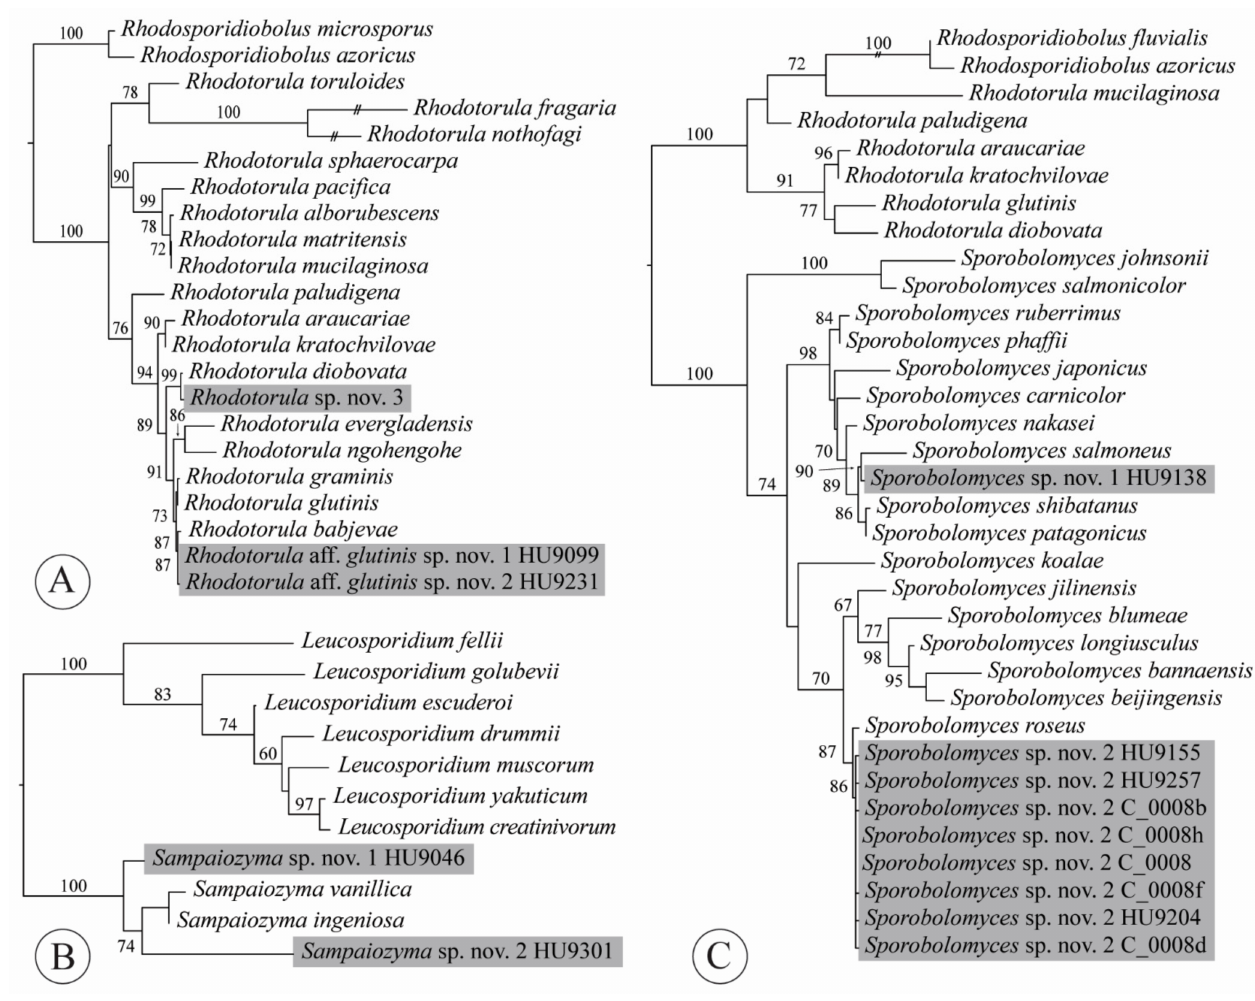
Figure 6. Phylogenetic reconstructions based on ITS sequences for the following genera: ( A ) Rhodotorula ; ( B ) Sampaiozyma ; and ( C ) Sporobolomyces . Topologies are the result of ML inference performed with IQ-TREE. For each node, the ML bootstrap (if ≥ 60) is presented above/below the branch leading to that node. Gray shading added for strains obtained from romaine lettuce samples during this